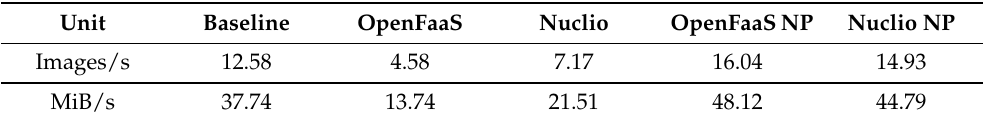
Figure 2. Image workload with null processing: OpenFaaS and Nuclio in comparison. Table 1. Peak input processing rates for image processing workload in Images/s and MiB/s with 3 MiB per image on